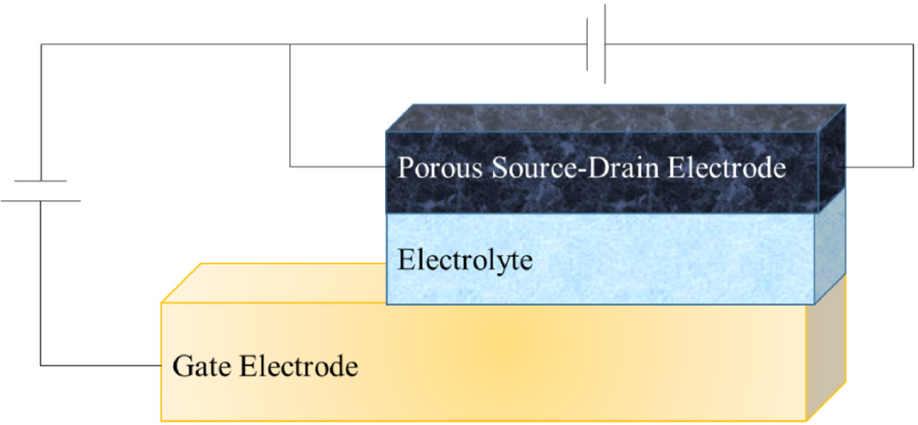
Figure 2. Measurement setup for electrical characterization of textile-based one-component OECT.